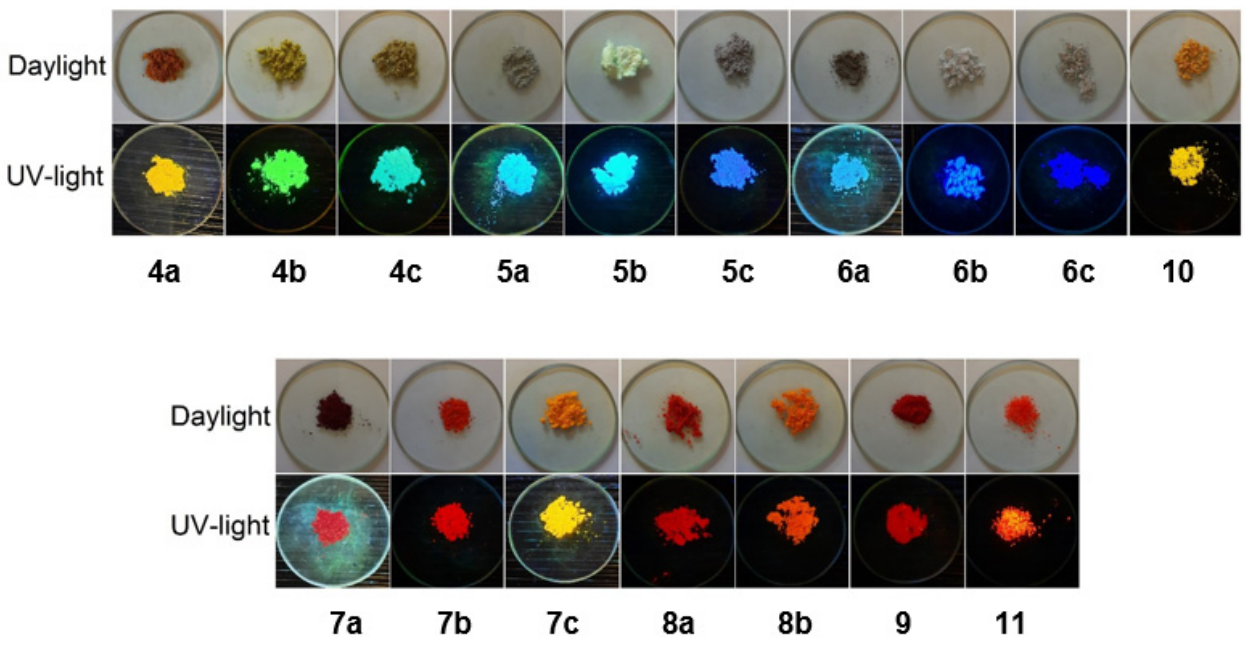
Figure 6. Emission of compounds 4 – 11 in solid state (powder). Photographs were taken in the dark upon irradiation with a hand-held UV lamp ( λ em = 366 nm).